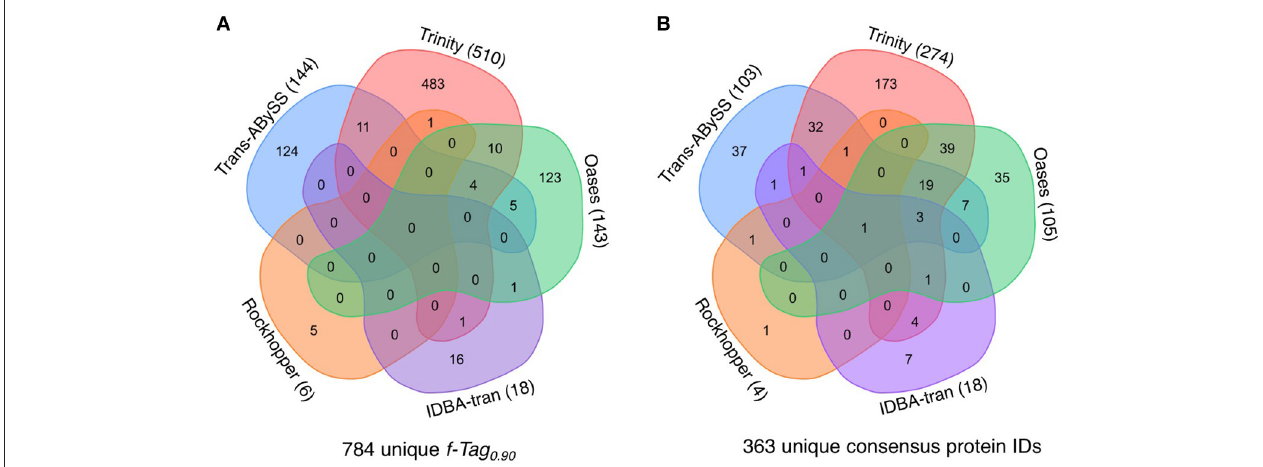
FIGURE 9 | Expression of proteins predicted from cRNA transcripts. The Venn diagram illustrates the shared and distinct (A) f-Tag 0.90 of cRNA transcripts and (B) consensus protein IDs from the analysis of the metaprotoemic data. All cRNA transcripts generated from the five cRNA assemblies were compiled into one single peptide datase for protein identification. The Venn diagram was generated using the tool at